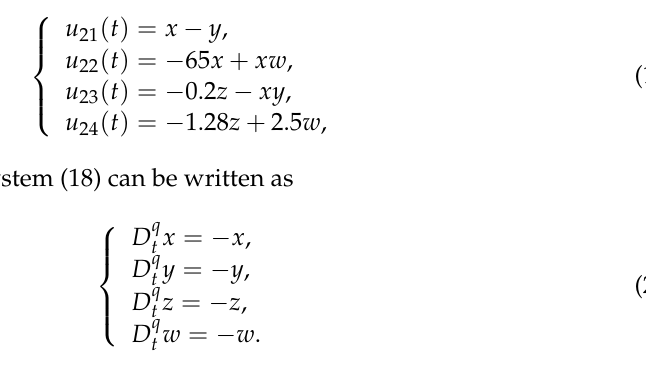
Figure 11. Time series of the controlled system (18) with the order q = 1, q = 0.75, and q =